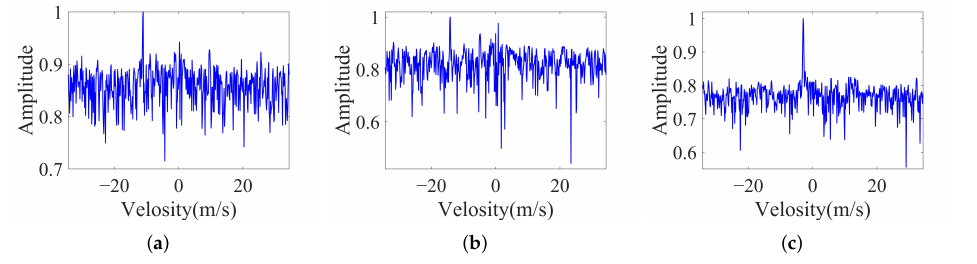
Figure 9. Magnitude normalized single frame signal. ( a ) Inspire2 UAV. ( b ) MAVIC Air2 UAV. ( c ) A bird.